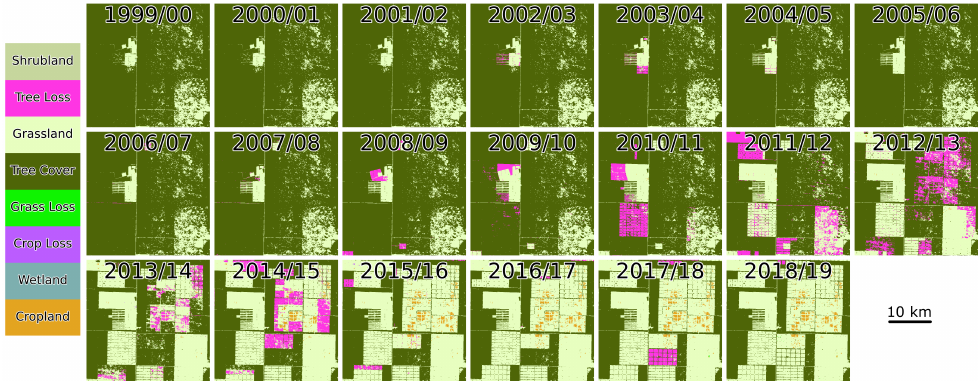
Figure 7. Annual land cover estimates in southwest Uruguay illustrating expansion of cropland onto herbaceous cover. The land cover legend is the same as the legend used in Figure 6. However, here we include additional categories to illustrate change: e.g., tree cover loss and herbaceous cover loss from time A to time B.